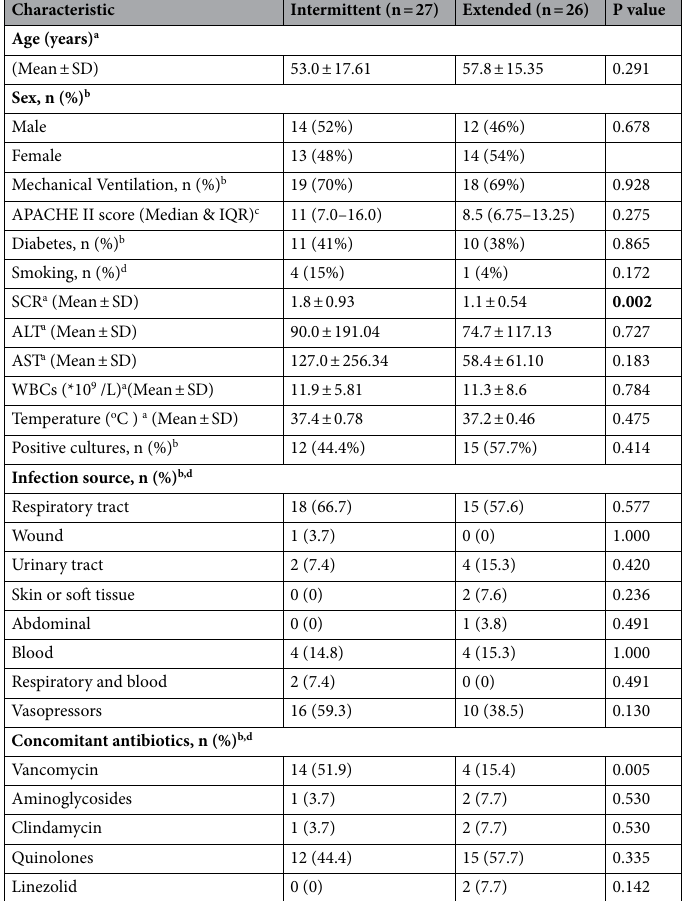
Table 1. Demographics and clinical characteristics of patients. All patients are Egyptians. Data are reported as mean ± SD, number (%) or median (interquartile range), ALT Alanine Transaminase, AST Aspartate Aminotransferase, APACHE II Acute Physiology and Chronic Health Evaluation, SCR Serum Creatinine, WBCs White blood cells. Results were compared using a Independent T-test, b chi-square test, c Mann-Whitney U test, d Fisher’s exact Test. P-value ≤ 0.05 is considered statistically significant. Significant P-values are in bold.